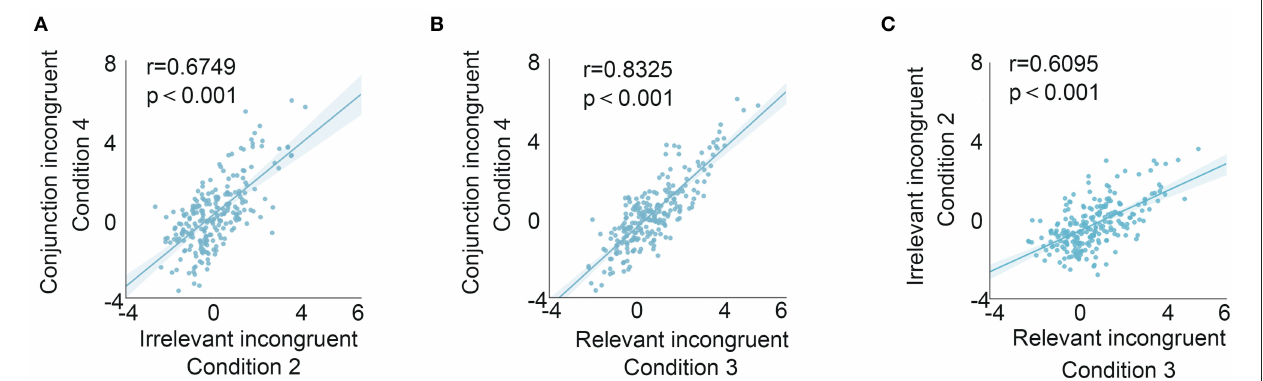
FIGURE 4 | Correlation of different conditions (mean t -value from 200 to 300ms post-S2 onset of each contact). The relationship between irrelevant incongruent and conjunction incongruent conditions (A) , the relationship between relevant incongruent and conjunction incongruent conditions (B) , and the relationship between relevant incongruent and irrelevant incongruent conditions (C) . The highest correlation was identified between relevant incongruent and conjunction incongruent conditions.